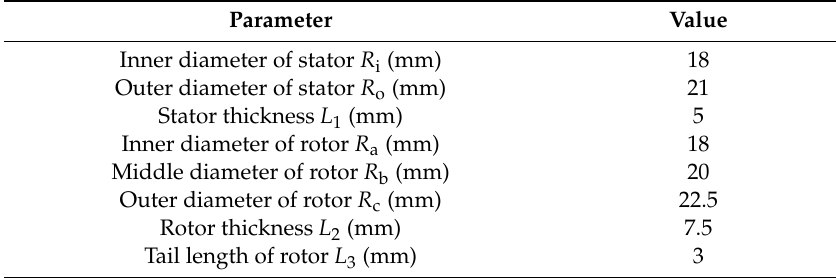
Table 2. Geometric parameters of the seal rings.